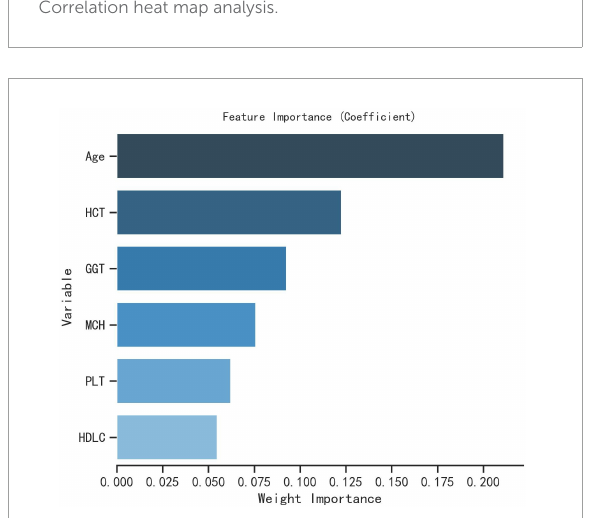
FIGURE4 Importance analysis of XGBoost model